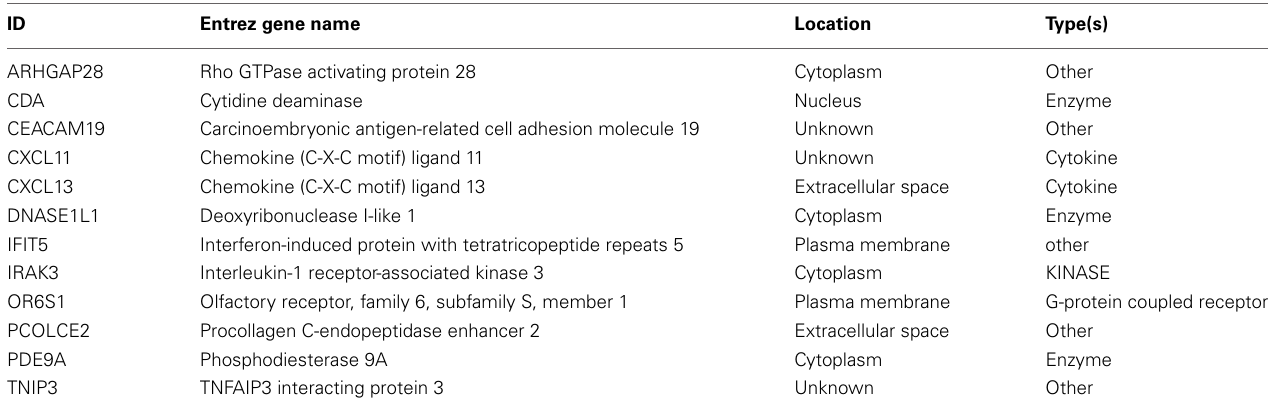
FIGURE 2 | Features selected by SVM-RFE machine learning method for tissue based analysis. Minimal number of features were selected for each data type providing maximum accuracy of classification for clinical outcome. Gene expression SVM-RFE results (A) and ROC Curve showing confidence intervals (B) based on top 12 genes are shown. on top 16 cytobands. Table 2 | Short list of 12 genes from